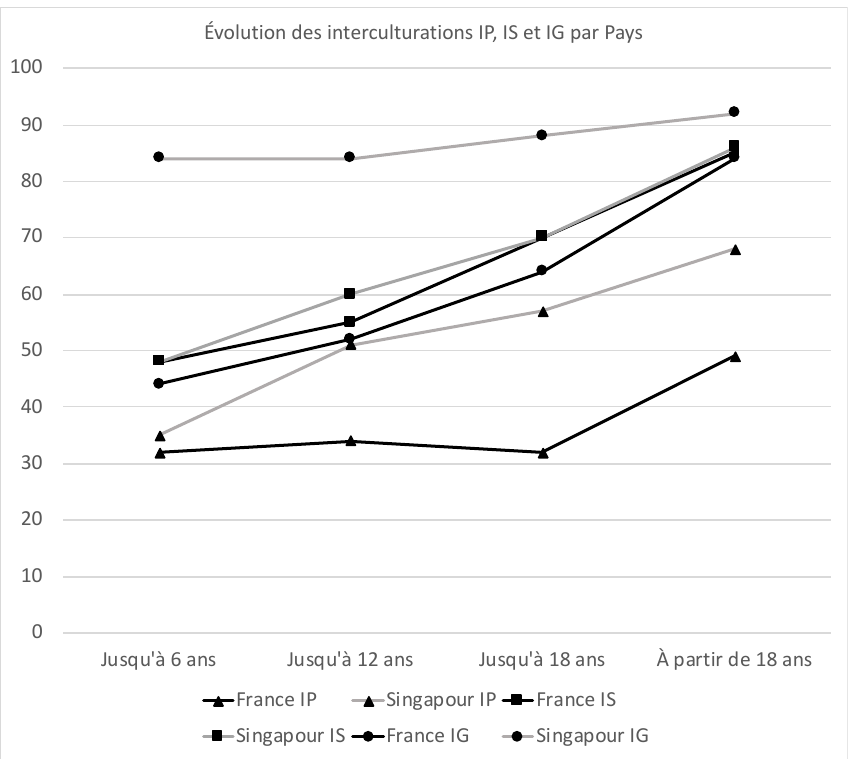
Figure 3. Evolution of interculturations by country (IP: intrapsychic ; IS: intersubjective ; IG: inter-group).